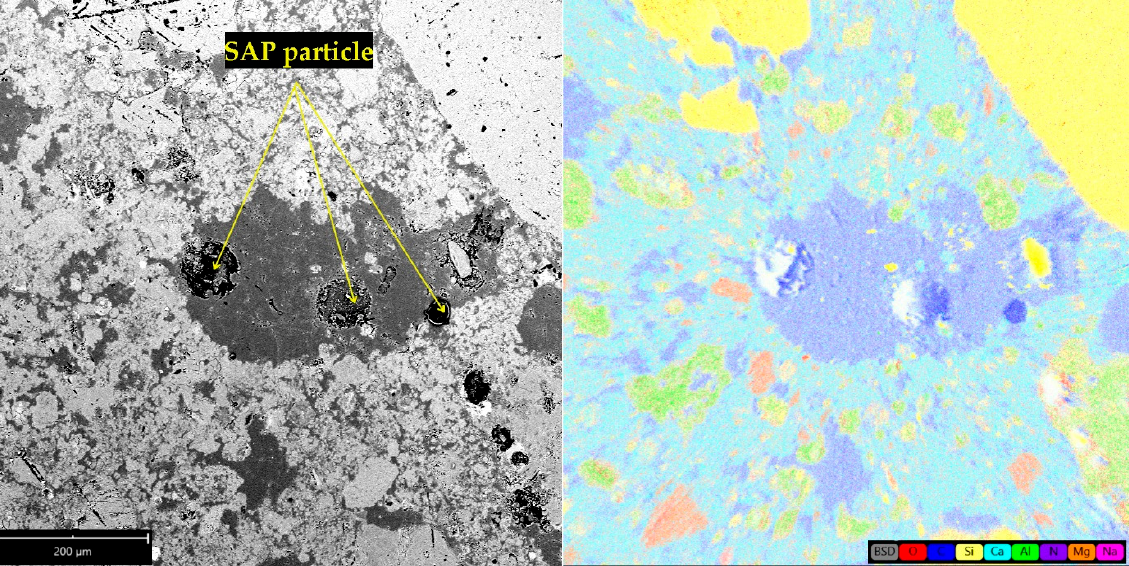
Figure 5. SEM image of the affected zone around the SAP core in hardened B1.5 mixture and element distribution map.